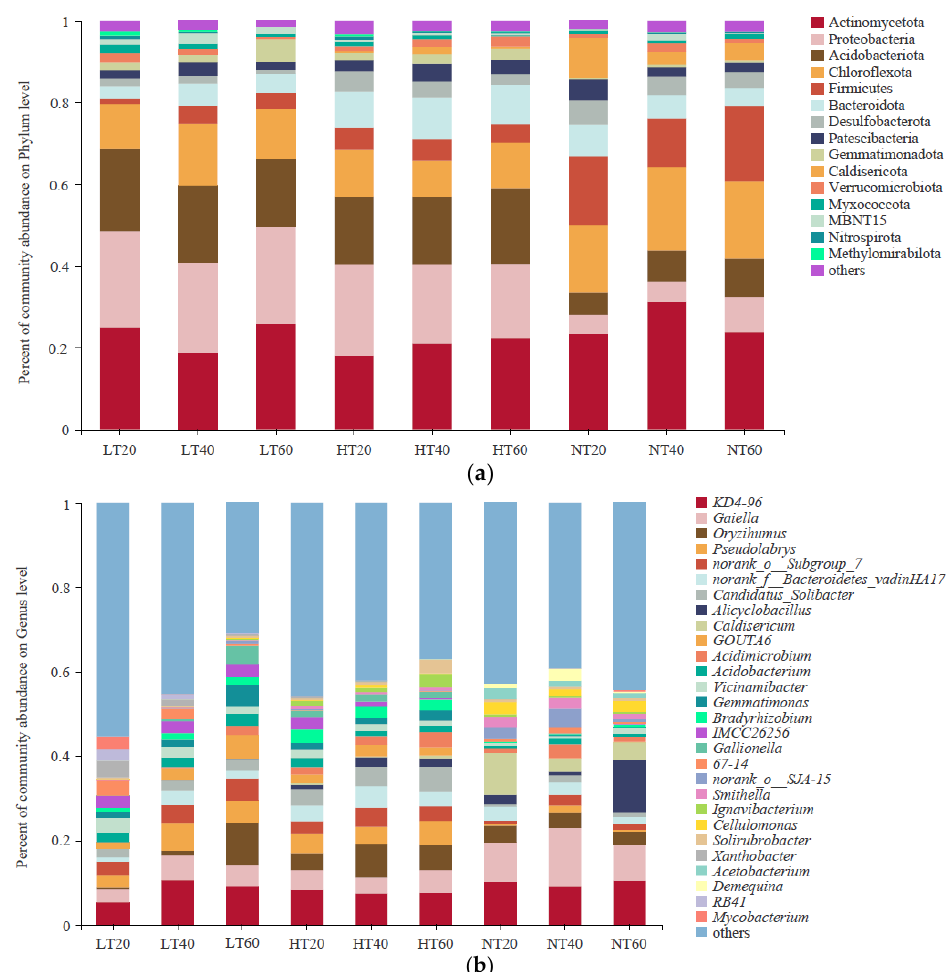
Figure 4. Characteristics of bacterial community composition at the phylum ( a ) level and genus ( b ) level. At the genus level, the soil samples were dominated by Gaiella